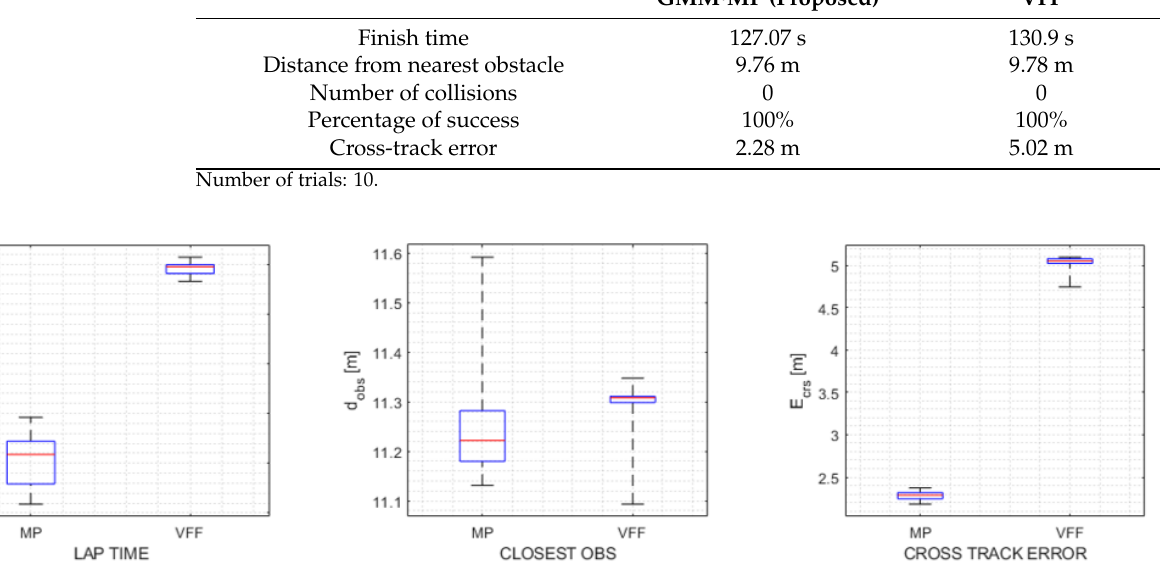
Figure 15. Avoidance performance of the USV in the scenario with multiple fixed